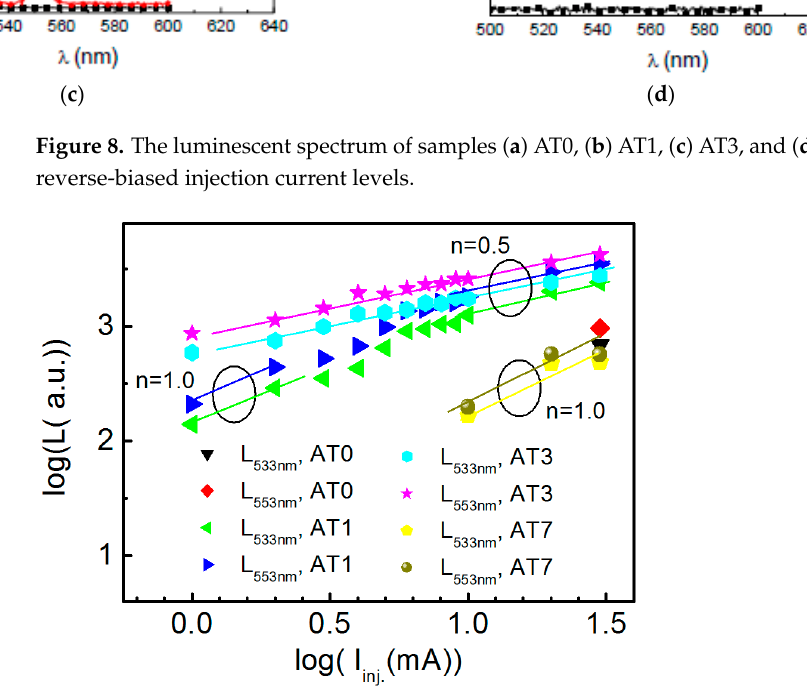
Figure 9. The log(L)) to log(Iinj.) plot with two characteristic emissions Er 3+ 2H 11/2 → 4I 15/2 (wave- length 533 nm) and 4S 3/2 → 4I 15/2 (wavelength 553 nm) for sample AT0, AT1, AT3 and AT7 measured at room temperature with different injection current level (I inj. ).